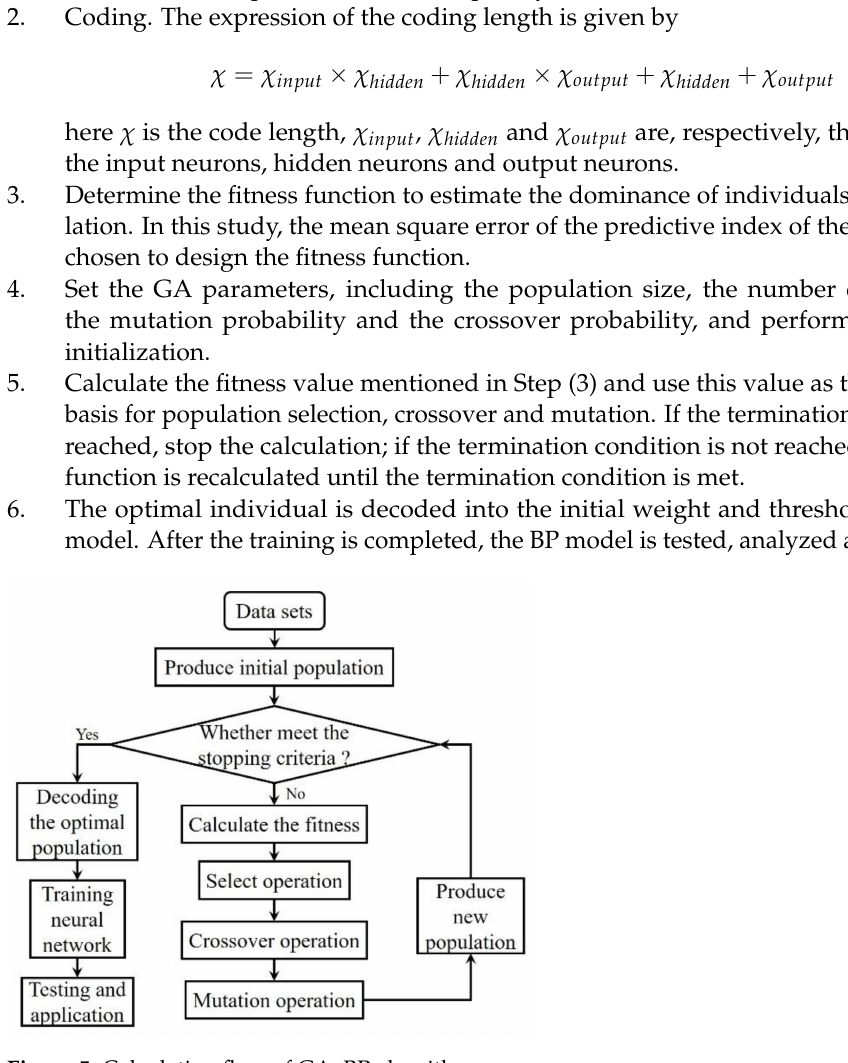
Figure 5. Calculation flow of GA–BP